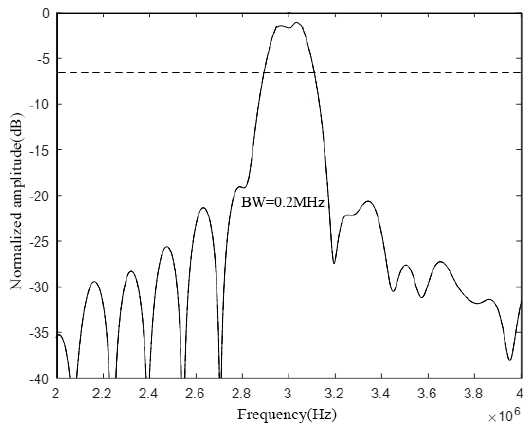
Figure 10. CMUT bandwidth with a cell spacing of 120 μ m.